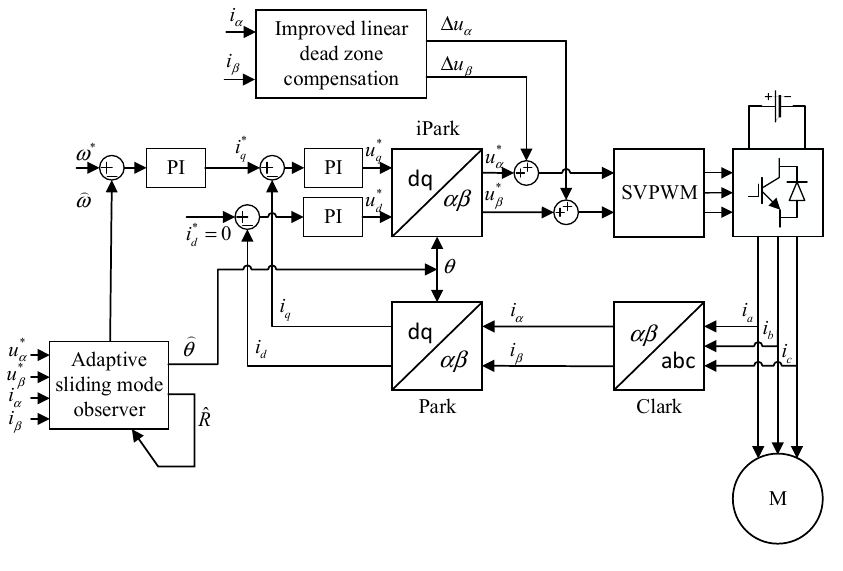
Figure 8. Block diagram of algorithm principle.